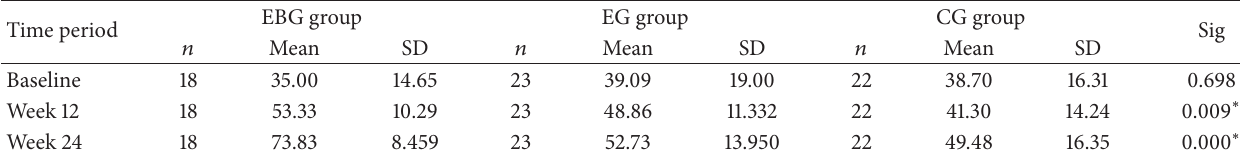
Table 4: Exercise self-efficacy scores for three groups across three time